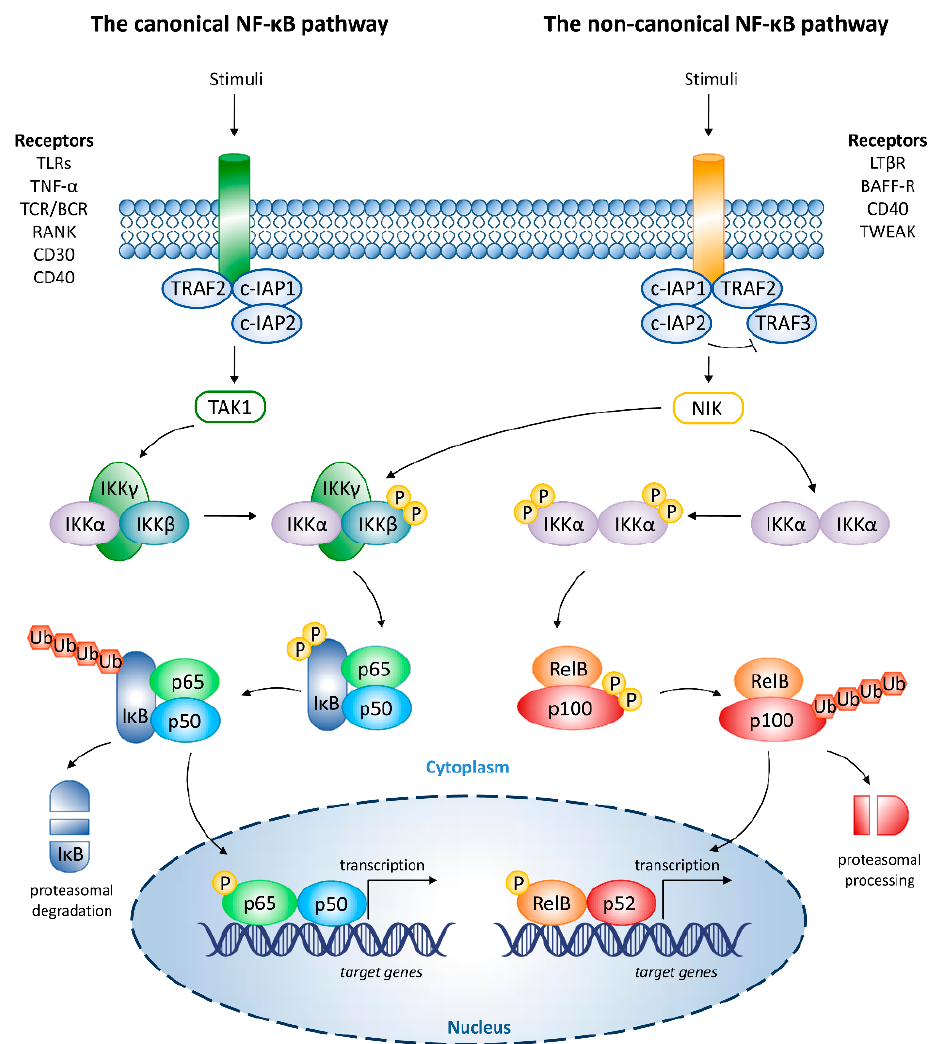
Figure 1. Canonical and non-canonical nuclear factor (NF)- κ B signaling. Activation and inhibition of NF- κ B signaling components are indicated by pointing and blunt arrows, respectively. BAFF-R, B cell-activating factor receptor; BCR, B-cell receptor; CD30, cluster of differentiation 30; CD40, cluster of differentiation 40; c-IAP1, cellular inhibitor of apoptosis protein-1; c-IAP2, cellular inhibitor of apoptosis protein-2; IKK α , inhibitor of κ B kinase α ; IKK β , inhibitor of κ B kinase β ; IKK γ , inhibitor of κ B kinase γ ; I κ B, inhibitor of κ B; LT β R, lymphotoxin- β receptor; NIK, nuclear factor- κ B-inducing kinase; P, phosphate group; RANK, receptor activator of nuclear factor- κ B; TAK1, transforming growth factor- β -activated kinase 1; TCR, T-cell receptor; TLRs, Toll-like receptors; TNF- α , tumor necrosis factor- α ; TRAF2, tumor necrosis factor receptor-associated factor 2; TRAF3, tumor necrosis factor receptor-associated factor 3; TWEAK, tumor necrosis factor-like weak inducer of apoptosis; Ub- ubiquitin moieties.